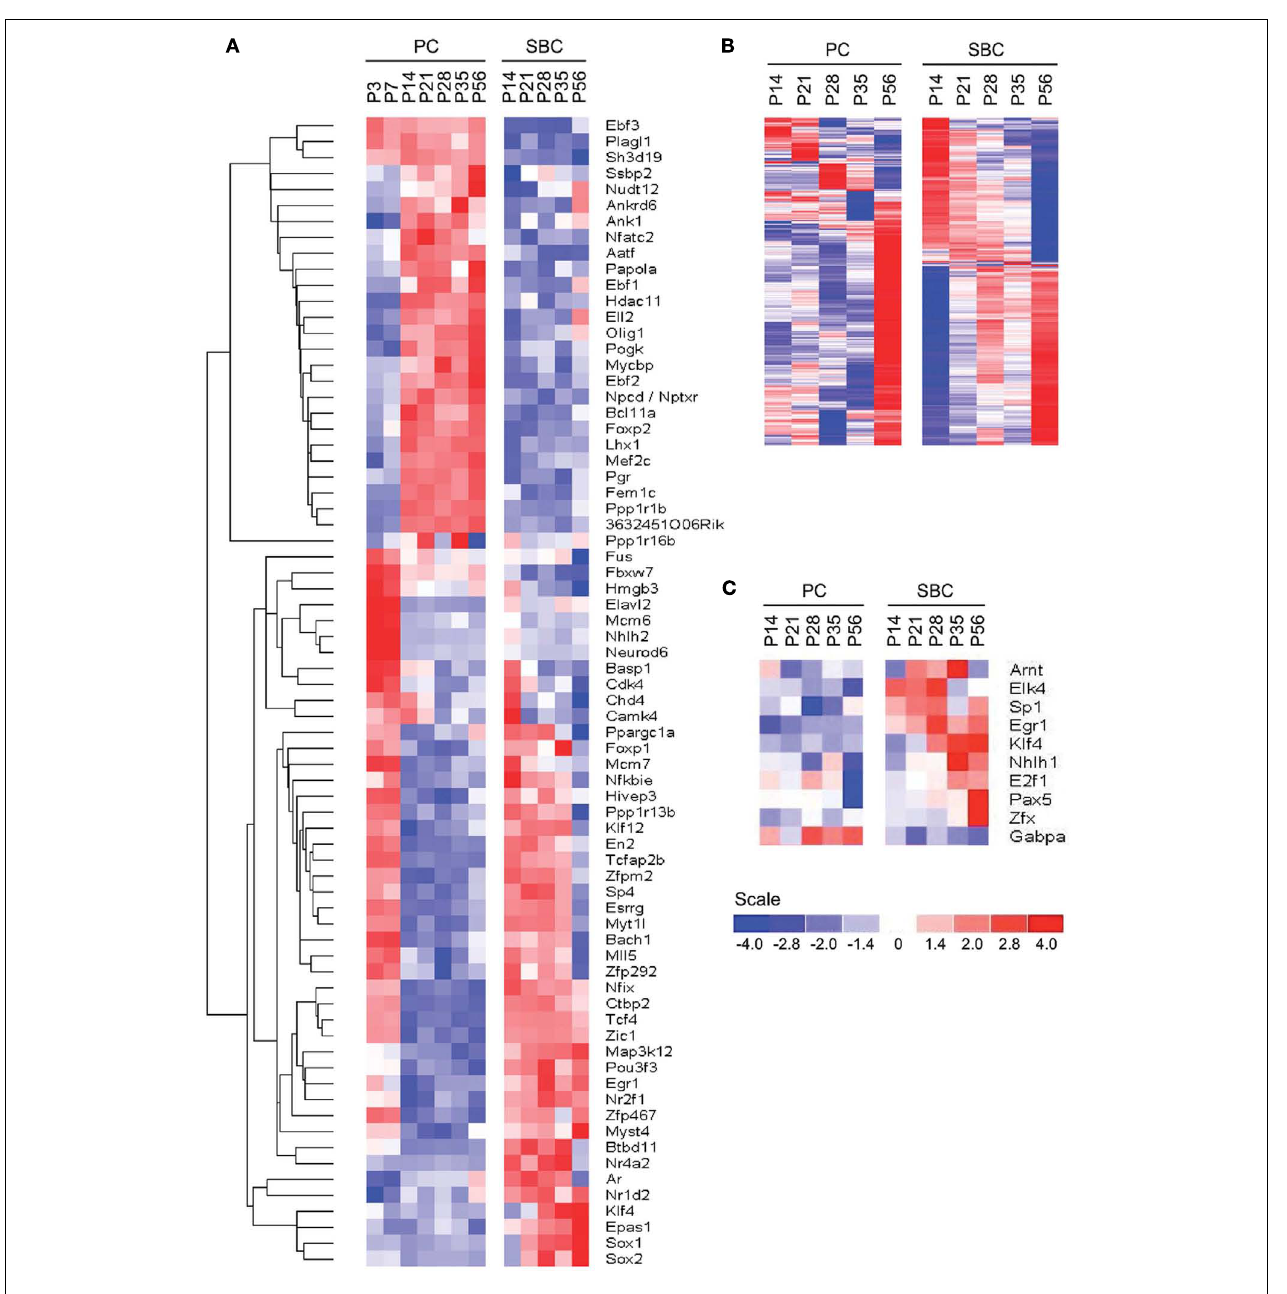
transcripts at each time points in both PC and S/BCs. (C) Promoter scanning for binding motifs of temporally co-regulated transcripts correctly identifies S/BC and PCTFs that match with cell-type specific microarray